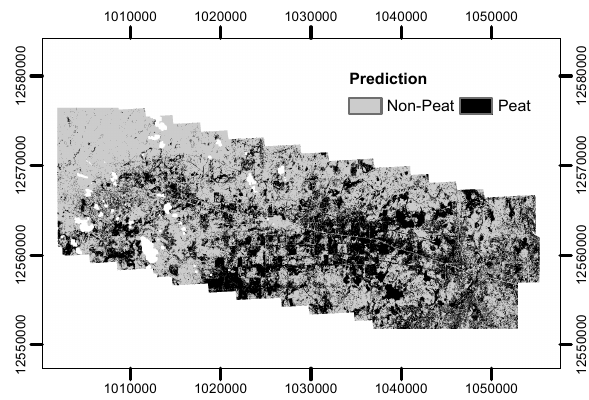
Figure 5 . Prediction map for the binary classification of peat for the Hearst study